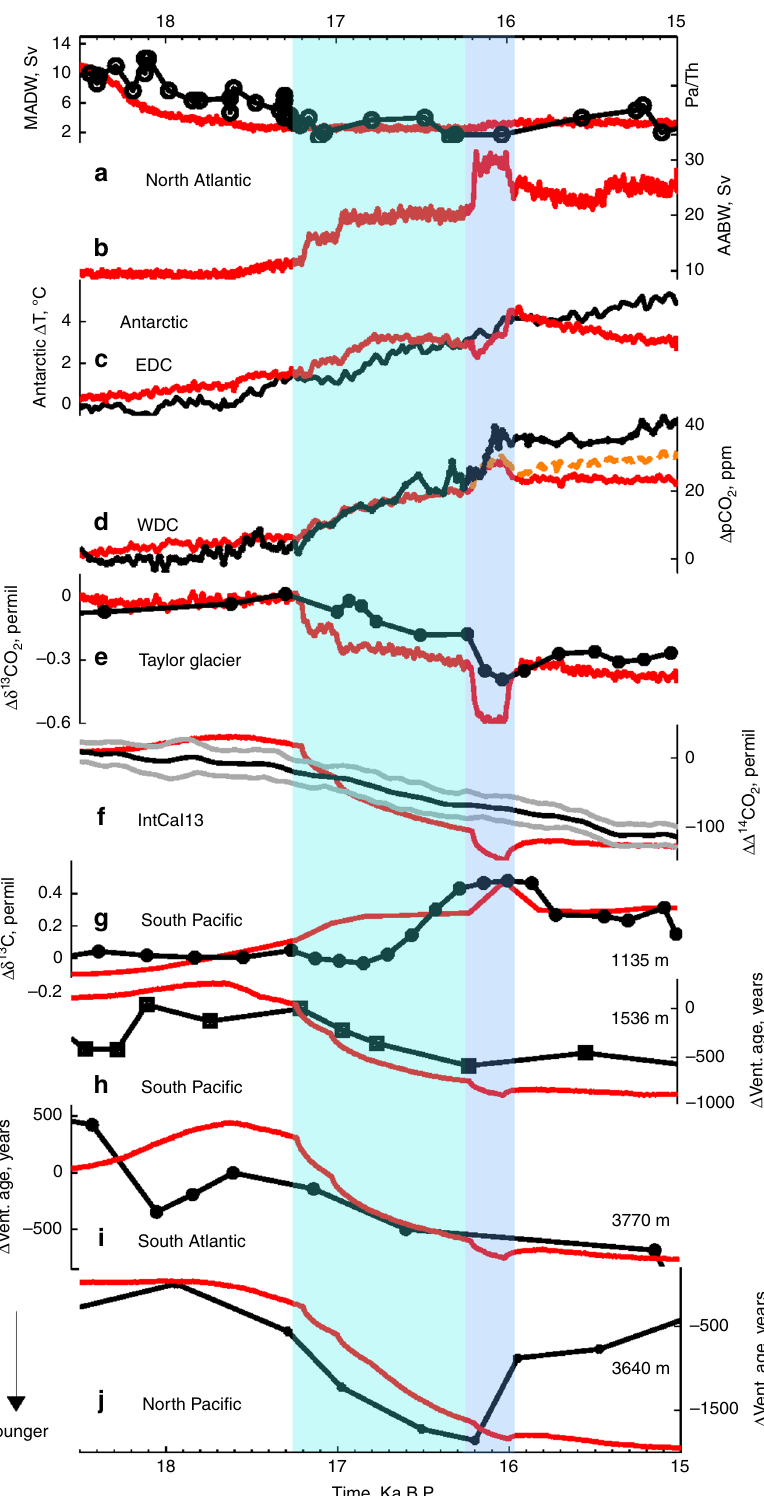
Fig. 1 Model-paleodata comparison across HS1. Time evolution of selected paleo records across HS1 (black) compared to the results of a transient simulation (red, LH1 – SO – SHW). a North Atlantic Pa/Th 81 and simulated NADW transport; b AABW transport; c Antarctic air temperature 16 ; d Atmospheric p CO 2 7 on the WD2014 chronology 82 ; e δ 13 CO 2 19 on the WD2014 chronology 82 ; f Δ 14 CO 2 20 ; g δ 13 C anomalies averaged over the intermediate South Paci fi c (170 – 180°E, 40 – 30°S, 1007 – 1443 m) and compared to a benthic δ 13 C record 55 ; Ventilation age anomalies from h the intermediate South Paci fi c 75°W – 50°W, 44°S – 48°S, 1443 – 1992 m 38 , i the deep South Atlantic 14°W – 8°W, 40°S – 48°S, 3300 – 4020 m 6 and j the deep North Paci fi c 152°W – 147°W, 51°N – 57°N, 3300 – 4020 m 33 . EDC and WDC, respectively, stand for EPICA Dome C and West Antarctic Ice Sheet Divide ice cores. 5 – 21 years moving average are shown for all the simulated variables except for Δ 14 CO 2 and the oceanic ventilation ages to fi lter the high-frequency variability. The dashed orange line in d includes a global ocean alkalinity decrease of − 6 μ mol L − 1 per 1000